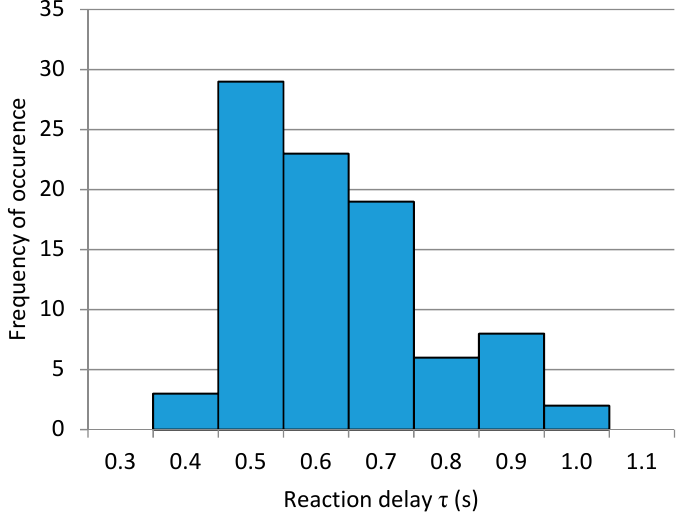
Figure 5. Histogram depicting the distribution of reaction delay parameter for the group of 10 military pilots.